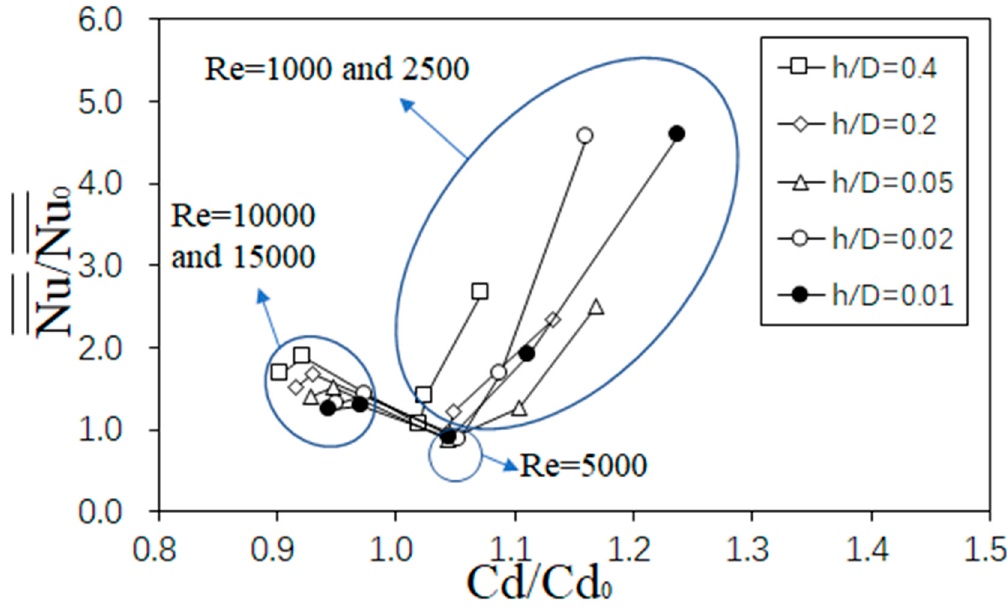
Figure 22. Spatially averaged Nusselt number ratios as dependent upon discharge coefficient ratio, for different micro cooling unit heights, and different Re j .